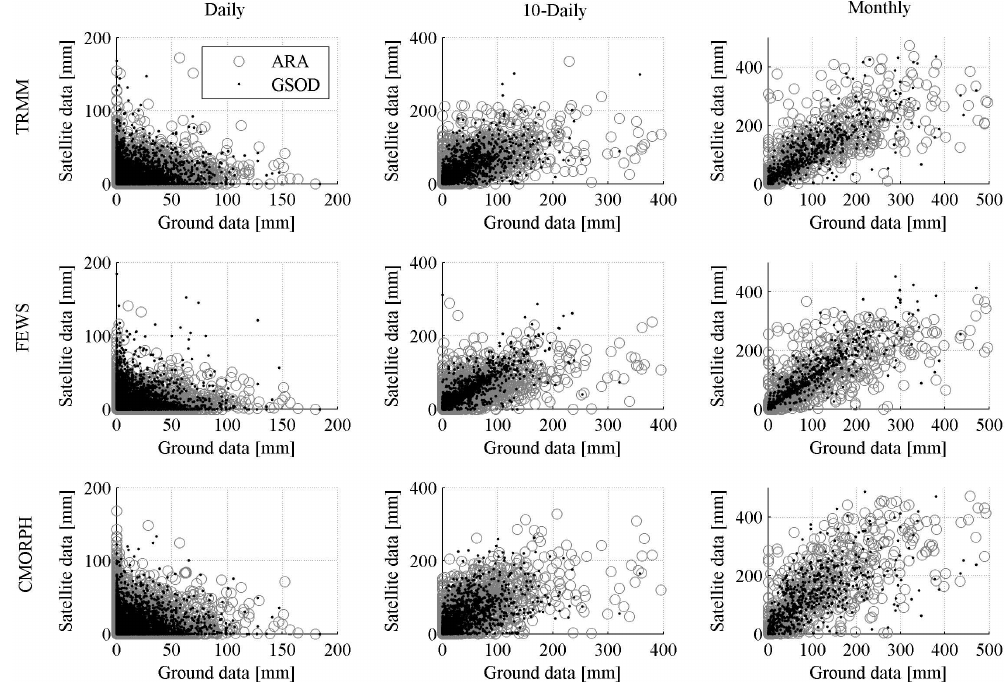
Fig. 5. Scatter plot of satellite based estimates versus ground data for daily, 10-daily and monthly time steps for the period 2003 to 2009.